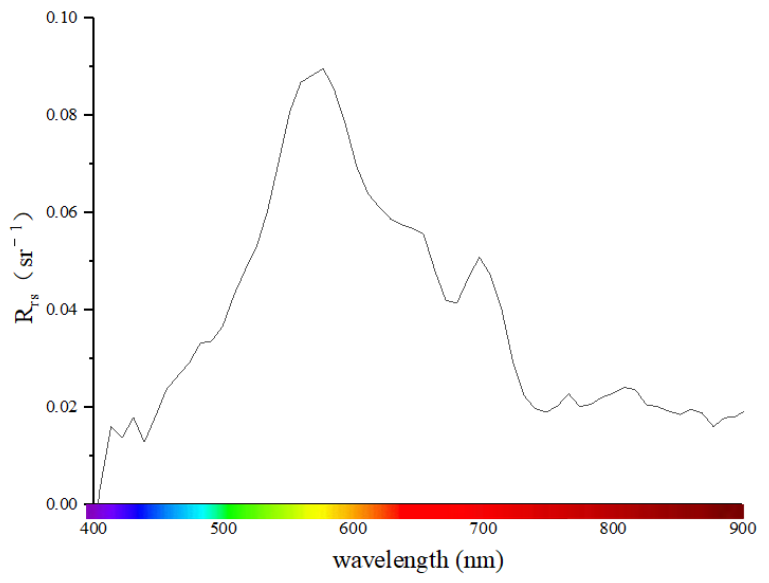
Figure 3. Water spectrum of Baiyangdian Lake.